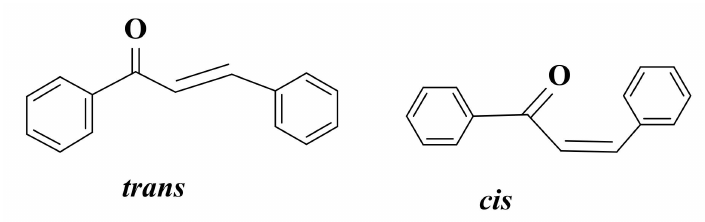
Figure 3. Cis and trans isomers of chalcones.